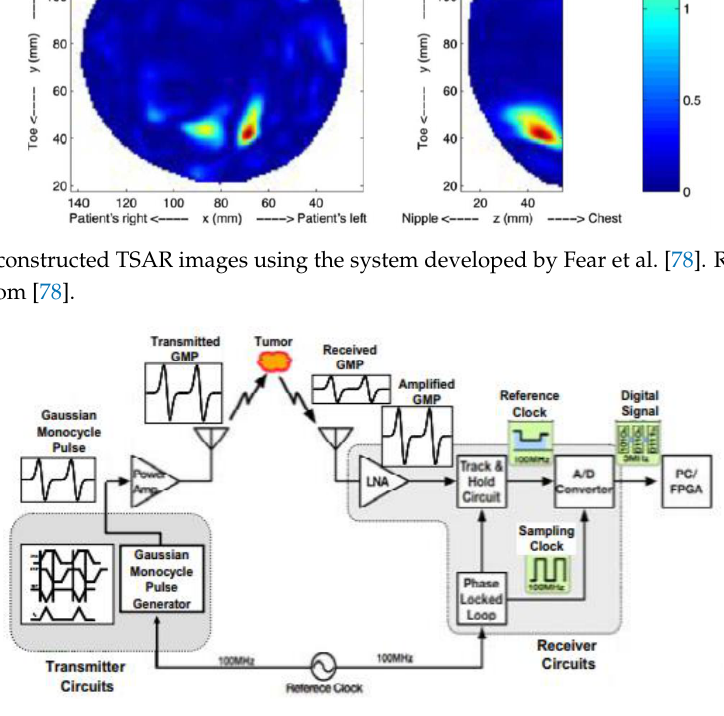
Figure 21. CMOS-based breast cancer detection system developed by Kikkawa et al. [79] consisting of transmitter and receiver circuits. The transmitter circuits contain a Gaussian mono-cycle pulse (GMP) generator, a power amplifier, and UWB antennas. The receiver circuits consist of a GMP receiver front-end low-noise amplifier (LNA) and a GMP data acquisition unit. Reprinted with permission from